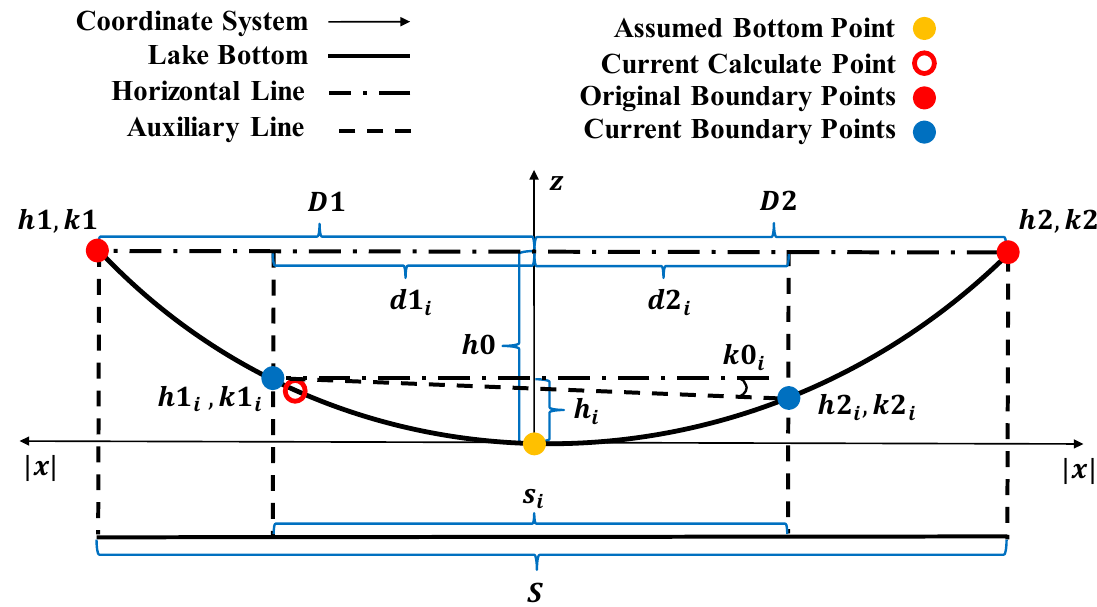
Figure 5. The calculation diagram of the MFM (morphologic function module). The black line represents the estimated lake bottom. The red circle is the pixel which is calculated now, and the red / blue solid points represent the linked original / current boundary points (same as in Figure 3). The yellow point represents the assumed bottom of the lake with zero slope. h 1 and h 2 are the elevations of original boundary points (actual lake surface level with the same values); h 1 i and h 2 i are the elevations at current boundary points, meanwhile they are both assumed to be equal to h i due to small k 0 i values. k 1 and k 2 are slope data with the corresponding direction from the SSD (Figure 4); and similarly, k 1 i and k 2 i are the slopes at current boundary points through calculation. Other parameters: S and s i represent the original / current calculation width, respectively; h 0 and h i represent the original / current calculation depths, respectively; D 1 and D 2 represent the horizontal distance between the assumed bottom and original boundary points; similarly, d 1 i and d 2 i represent the horizontal distance between the assumed bottom and current boundary points. Furthermore, the k 0 i is a small decimal deviation because the data is recorded by double float format.